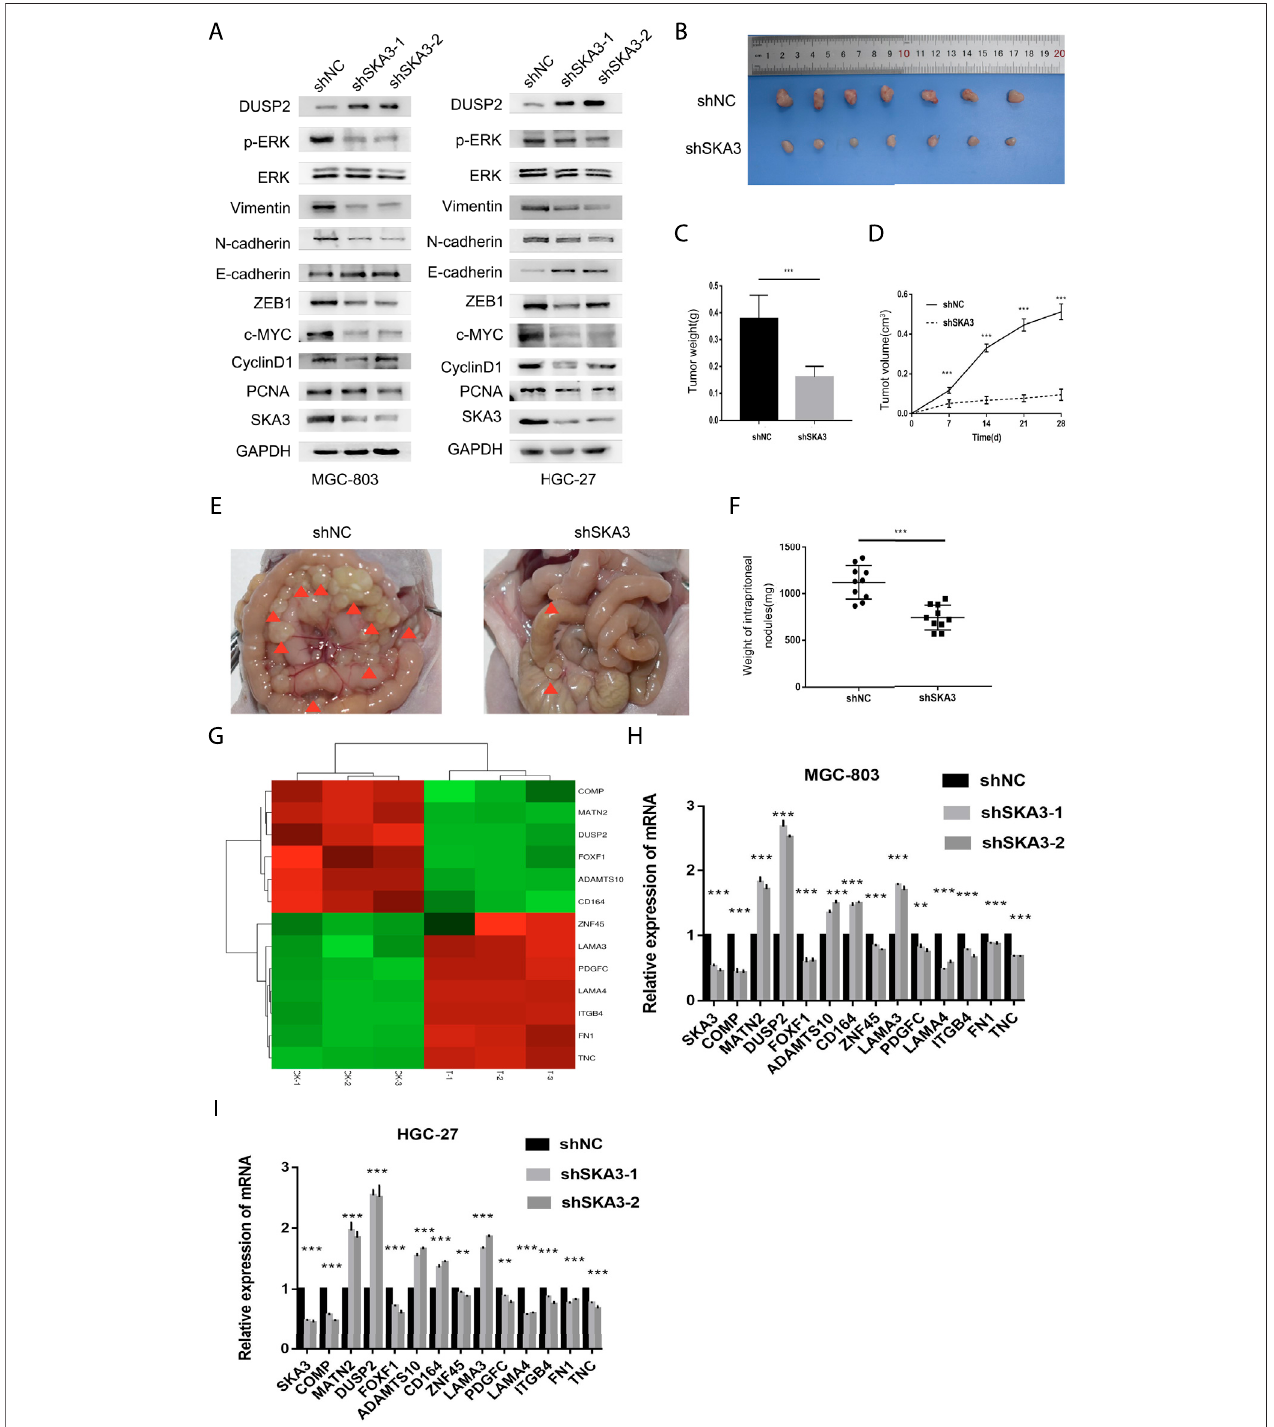
FIGURE 4 | SKA3 regulates epithelial-mesenchymal transition (EMT), MAPK/ERK pathway in vitro and regulates the aggressive behaviors in vivo . (A) Silenced for SKA3 inhibits proliferation, EMT and MAPK/ERK related proteins in MGC-803 and HGC-27. (B) Tumor growth assessment in subcutaneous tumor model of gastric cancer. (C) Tumorweightwasmeasured inshSKA3and controlgroups. (D) Tumorvolumewasmeasured inshSKA3and controlgroups. (E) Intraperitonealmetastasis model showed that the metastatic nodules derived from shSKA3 and control groups. (F) Intraperitoneal metastasis tumor weight was measured in shSKA3 and control groups. (G) Microarray heatmap showed differentially expressed genes. (H) Differentially expressed genes were screened by qRT-PCR in MGC-803. (I) DifferentiallyexpressedgeneswerescreenedbyqRT-PCRinHGC-27. (J) WesternblotofDUSP2levelsinthesh-SKA3cells.Dataareshownasmean±SDfortriplicate experiments. The two-tailed Student ’ s unpaired t -test was used. * p < 0.05, ** p < 0.01, *** p < 0.001.